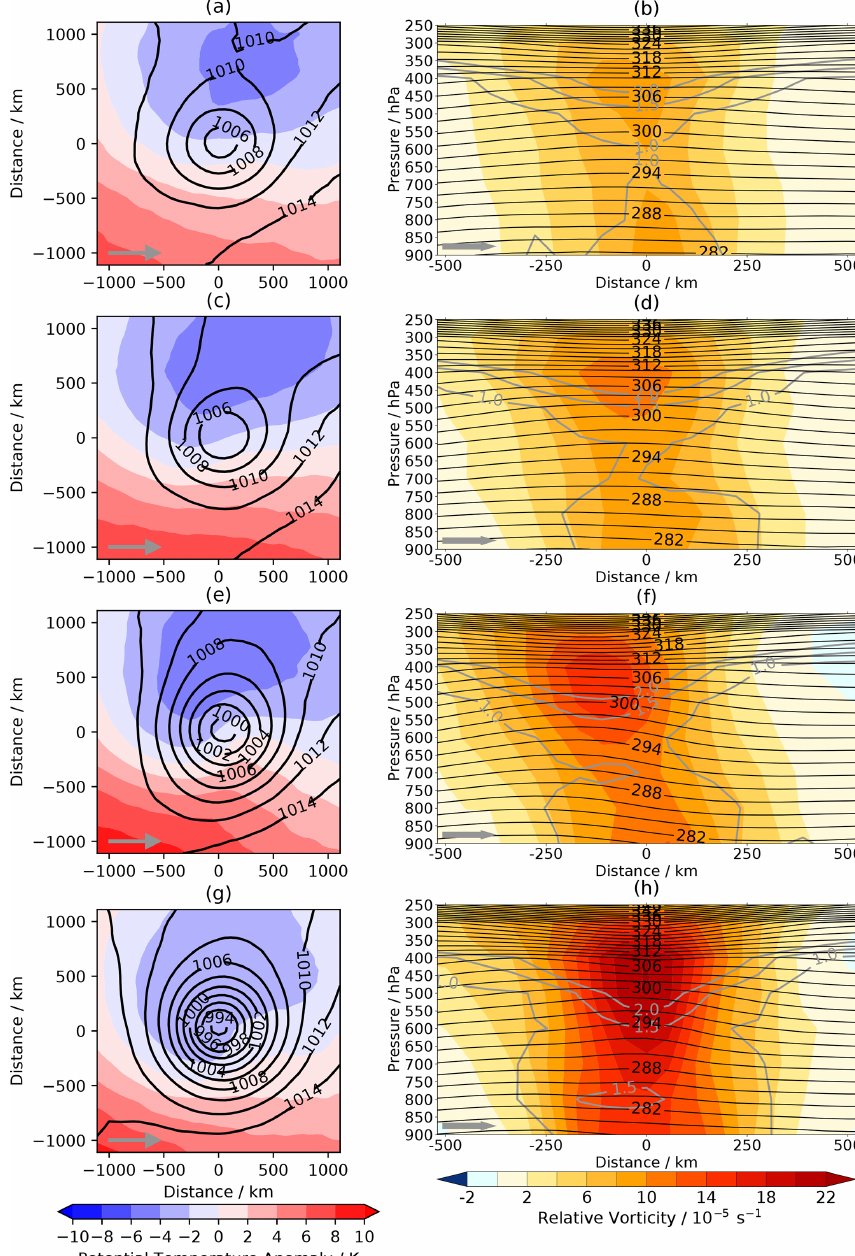
Figure 9. Composite fields of the 200 most intense matched Arctic cyclones at times (a, b) 2d prior to maximum growth rate, (c, d) 1d prior to maximum growth rate, (e, f) at the maximum growth rate and (g, h) at the maximum intensity. Left column shows the horizontal distributions of θ 900 anomalies relative to the domain average (shaded) and MSLP (hPa). Right column shows vertical cross sections of ξ in the along-track direction (shaded). Thick, grey contours: potential vorticity (1, 1.5 and 2PVU shown). Black contours: θ (interval 2K). Grey arrow in each panel indicates the direction of cyclone motion. The composites use full-resolution (rather than filtered) fields.